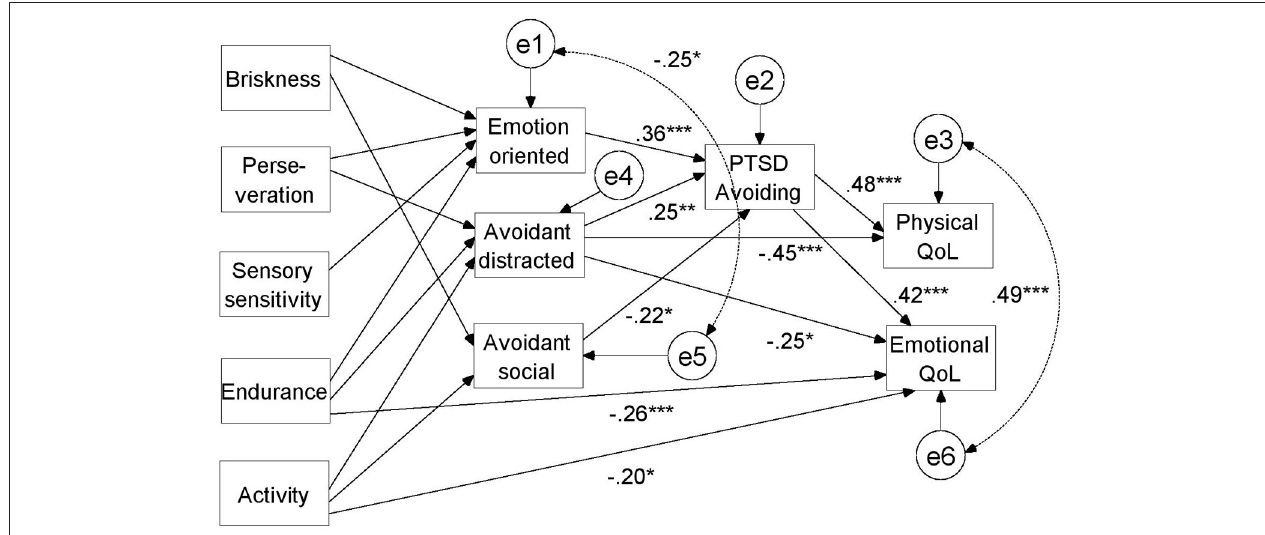
FIGURE 2 | Final model of associations between temperamental traits, stress coping styles, PTSD symptoms, and quality of life with standardized regression coefficients.